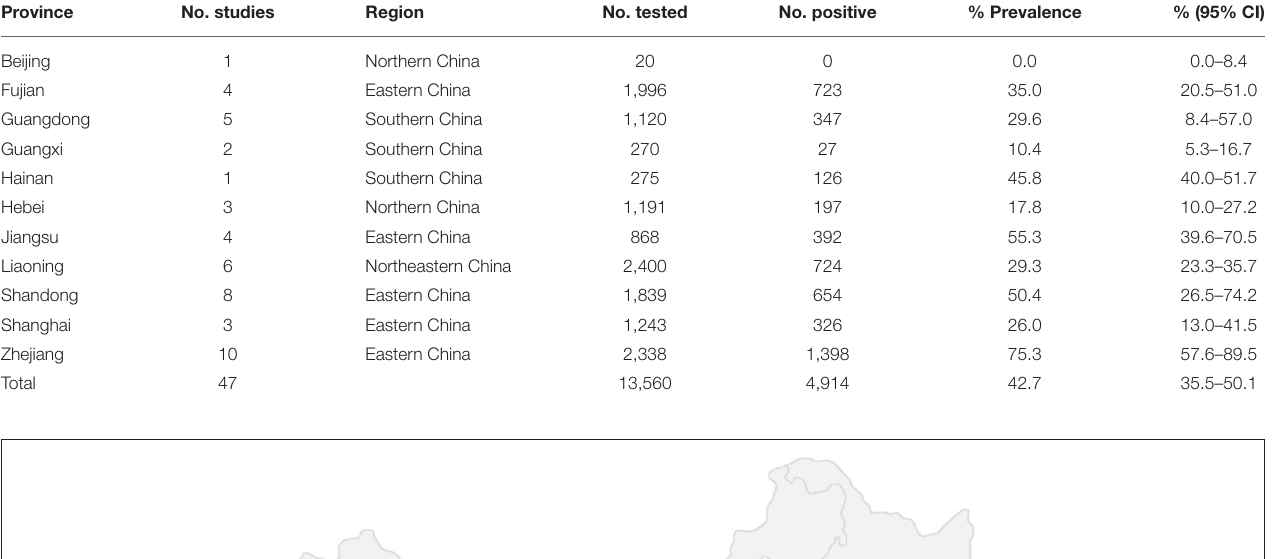
TABLE 6 | Estimated pooled prevalence of anisakid nematodes by provinces in China. Province